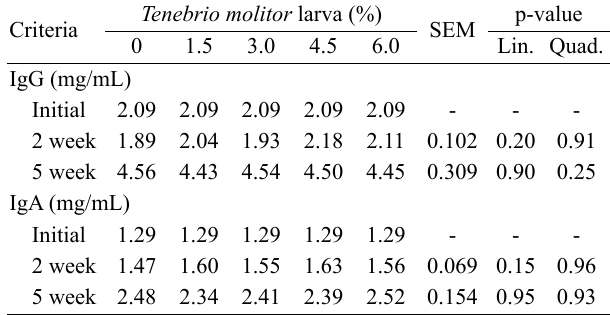
Table 7. Effect of dried mealworm larvae supplementation on serum IgG and IgA concentration in weaning pigs 1